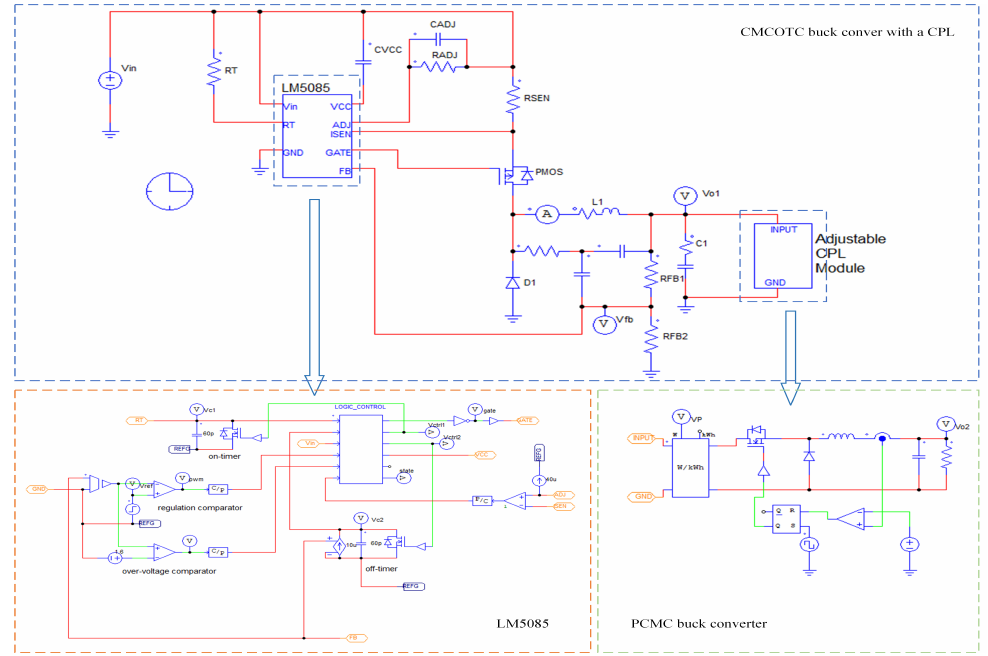
Figure 7. Schematic of CMCOTC buck converter with CPL in